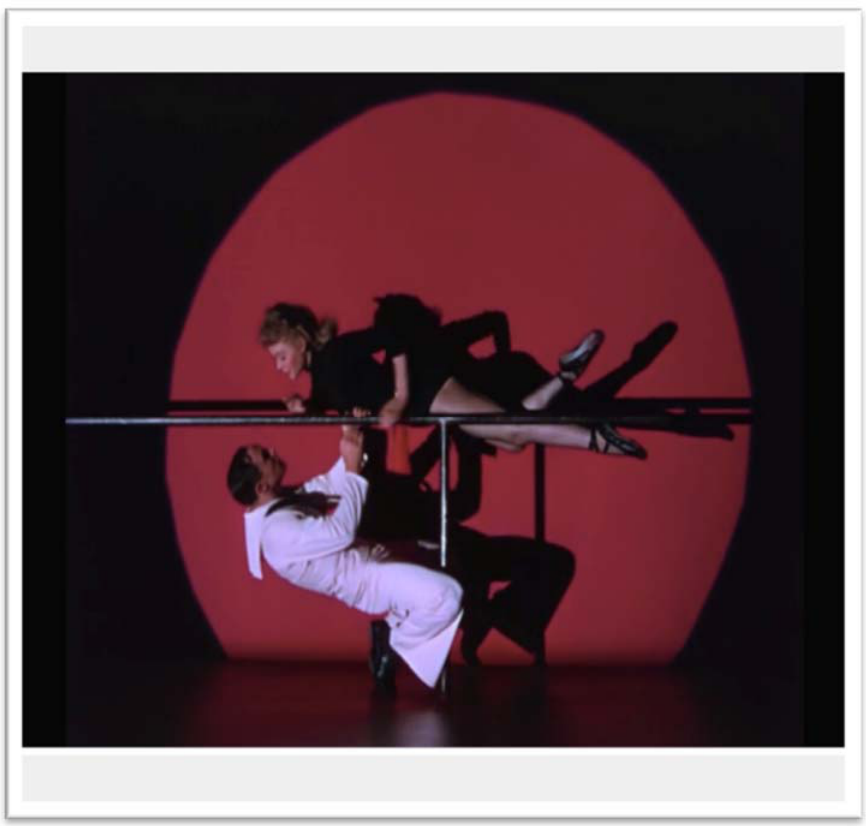
Figure 3. Screenshot of Gene Kelly and Vera-Ellen in “A Day in New York” from On the Town (1949). Kelly has assumed the position tested out in rehearsal by Romero in Figure 2.